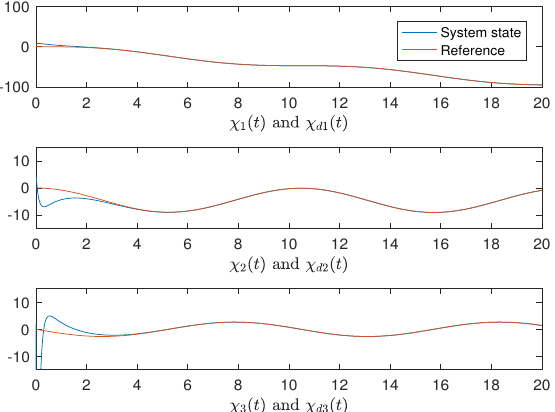
Figure 1. The tracking performance of three state variables χ 1 , χ 2 and χ 3